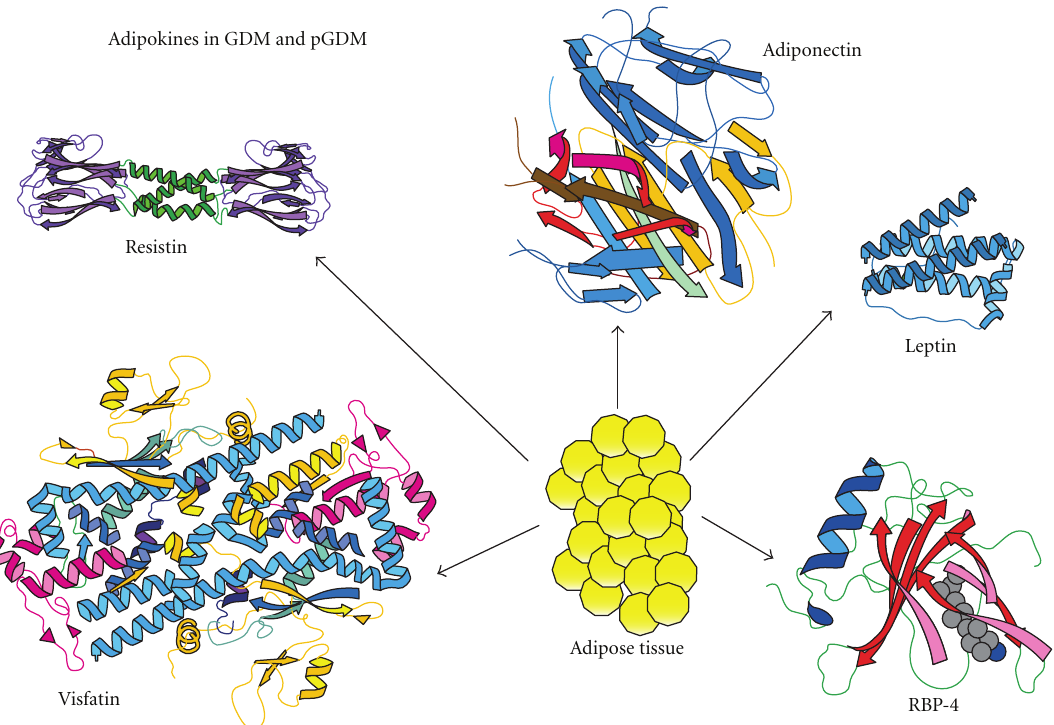
Figure 1: Molecular structure of the main adipokines produced by adipose tissue in GDM and pGDM. Adiponectin is a 244-amino-acid polypeptide that decreases as adipose tissue increases; it enhances insulin action and is decreased in pGDM and GDM. Leptin is a 167- amino-acid protein; it causes insulin action to increase and its levels show variability with respect to GDM and pGDM. Resistin (or adipose tissue-specific secretory factor) has 108 amino acids in the prepeptide form; its action on insulin has yet to be clarified. RBP-4 is a 183- amino-acid protein which reduces insulin action. Both resistin and RBP-4 levels appear increased, decreased, or unaltered in GDM but are uniformly increased in pGDM. The visfatin molecule consists of 491 amino acids; it facilitates insulin action and increases in GDM, while its actions in pGDM need further